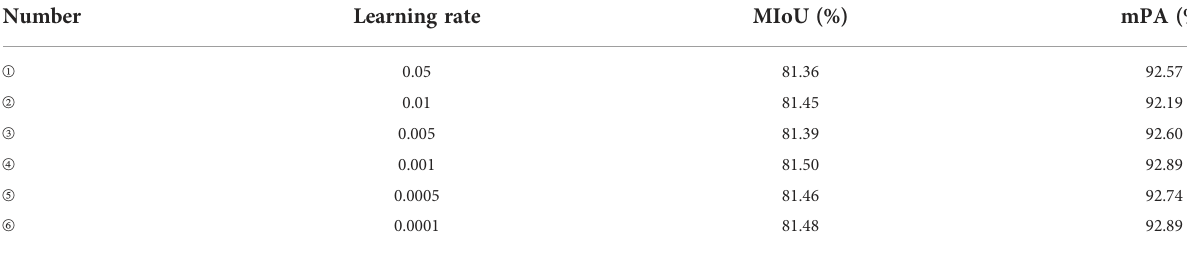
TABLE 4 Comparison of network training at different learning rates.